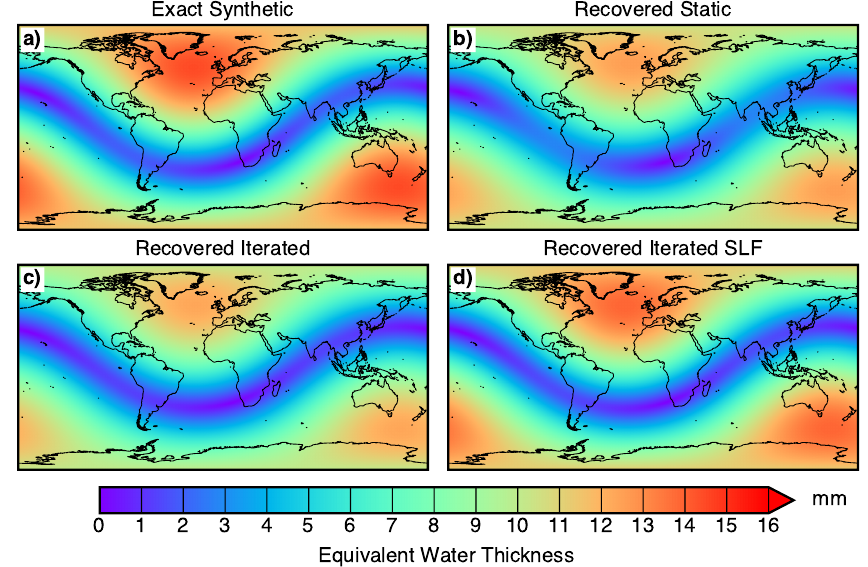
Figure 4. Annual amplitudes of ( a ) actual and ( b–d ) recovered degree one surface mass variations in mm water equivalent calculated from synthetic fields of mass variability derived from GLDAS NOAH v2.1 land surface model outputs [53], RACMO2.3 surface mass balance outputs [54,55] and ice sheet mass balance estimates [56]. In the recovered solutions, the land-sea exchange is estimated using ( b ) a static seasonal geocenter from Chen et al. [7], ( c ) an iterated self-consistent geocenter, and ( d ) an iterated self-consistent geocenter taking into account the effects of self-attraction and